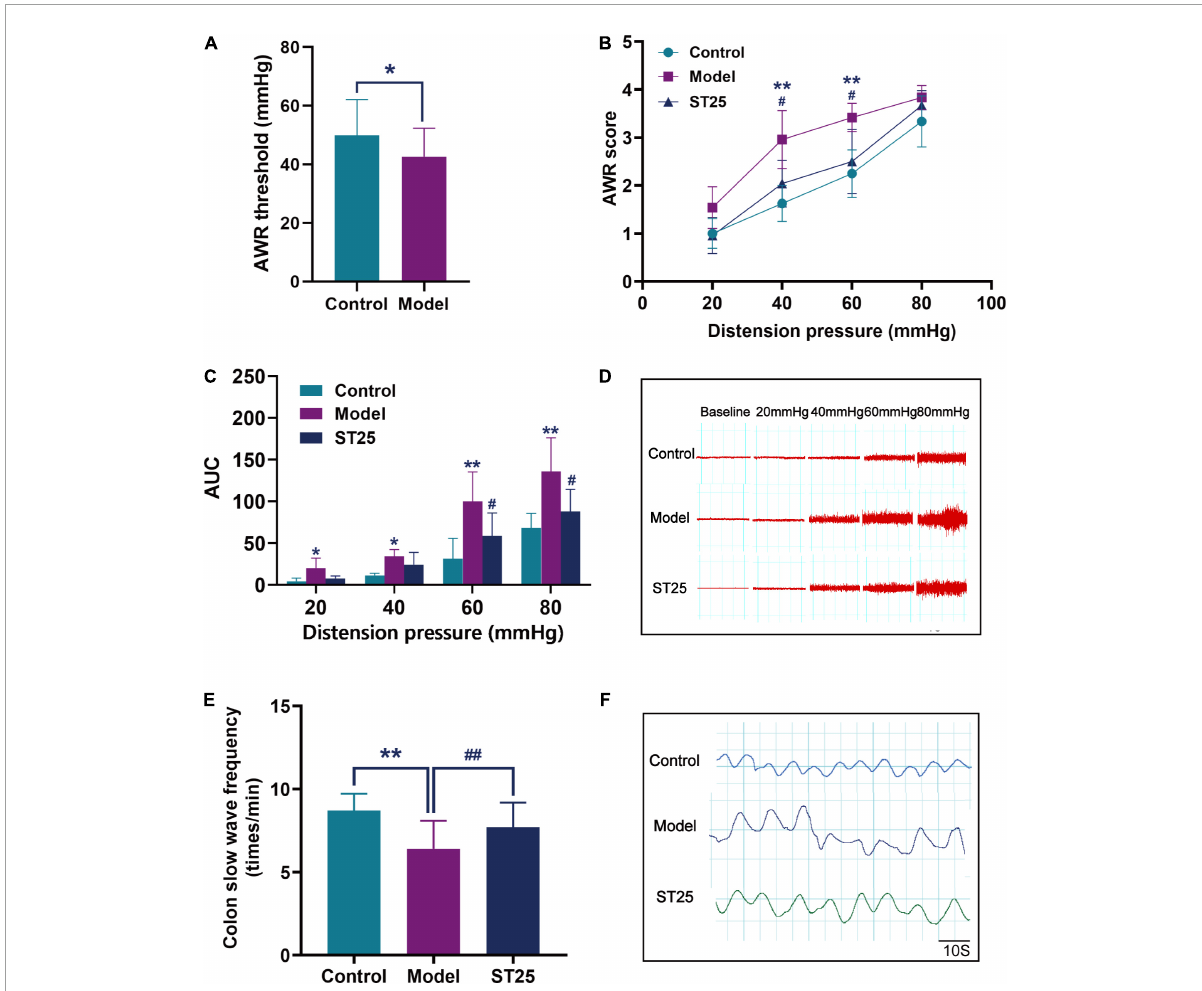
FIGURE2 The effect of electroacupuncture at ST25 on pain threshold and colonic motility in irritable bowel syndrome (IBS) rats. (A) Validation of the animal model of the IBS model. The visceral pain threshold pressure was measured using the abdominal withdrawal reflex (AWR) test in IBS (model) rats ( n = 42) and control (normal) rats ( n = 21). (B) AWR scores under different pressure (20, 40, 60, and 80 mmHg), n = 8. (C) The area under the curve (AUC) of EMG activity in the external oblique muscle in response to graded distension pressures, n = 5. (D) Representative EMG under different pressure (20, 40, 60, and 80 mmHg). (E) Colon slow-wave frequency, n = 8. (F) Representative colonic EMG graphs. Data are expressed as mean ± standard error, * p < 0.05, ** p < 0.01 compared with the control group. # p < 0.05, ## p < 0.01 compared with the model